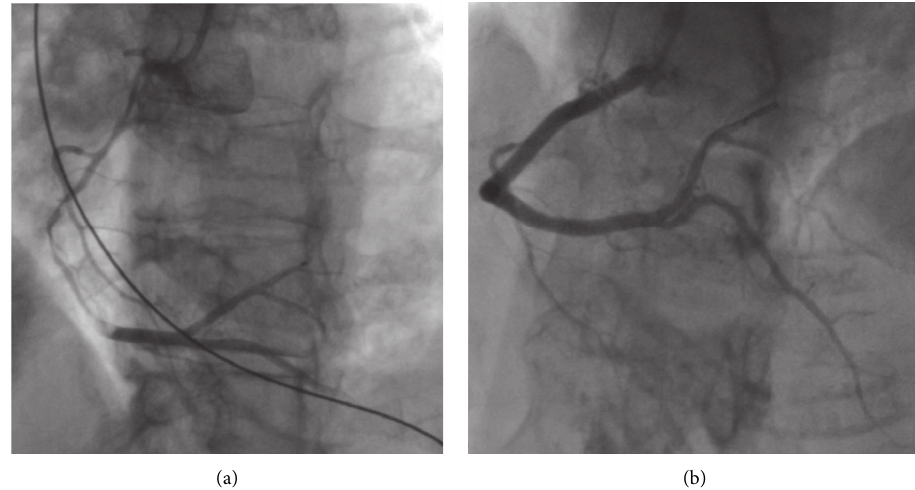
Figure 1: (a) Type 2A SCAD of the proximal to distal RCA. (b) Successful stenting of the proximal to distal RCA with final TIMI 3 flow.